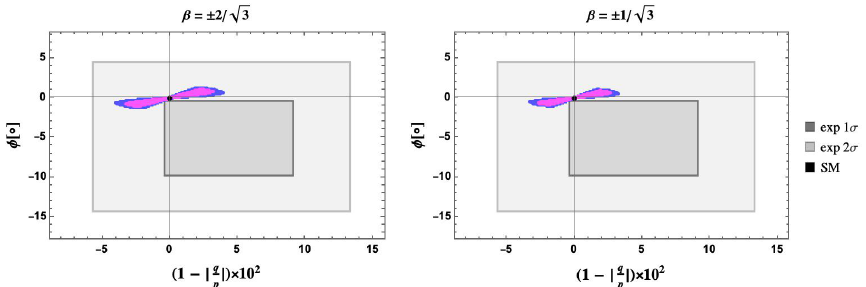
Figure 2 . Correlation between the phase φ (in degrees) in D 0 − D 0 mixing (3.4) and the function (1 − | q/p | ) measuring the deviation of | q/p | from unity, obtained in the 331 models for different values of the parameter β and for M = 1 TeV. The magenta (blue) region is obtained imposing Z 0 that the mixing observables x lie in the experimental range in (3.9) within 1 σ (2 σ ). The gray D , y D (light gray) regions show the 1 σ (2 σ ) range for ( φ, | q/p | ) in eq. (3.9).